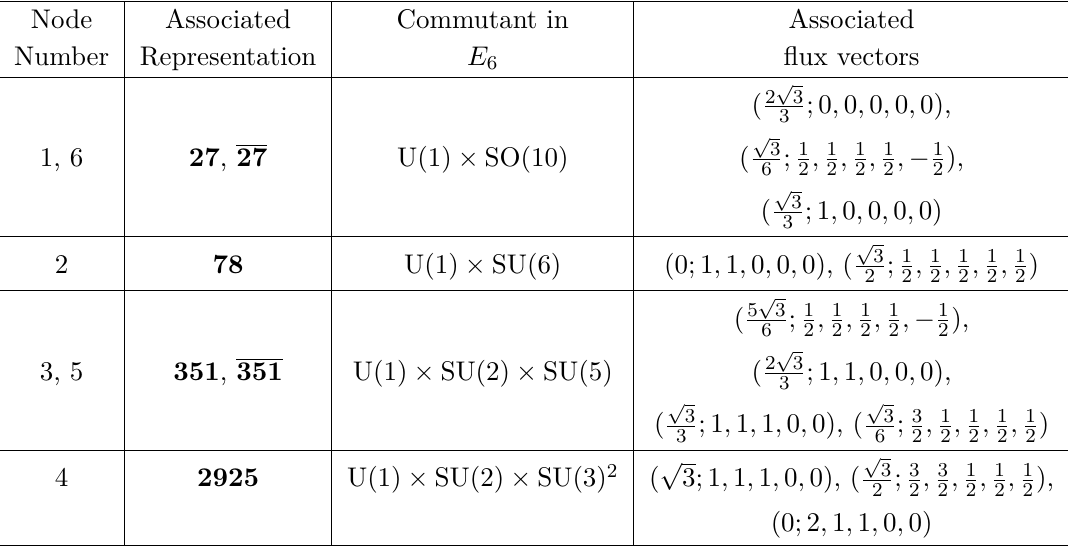
Table 4 . Flux vectors associated with various representations of E 6 and their preserved symmetry.